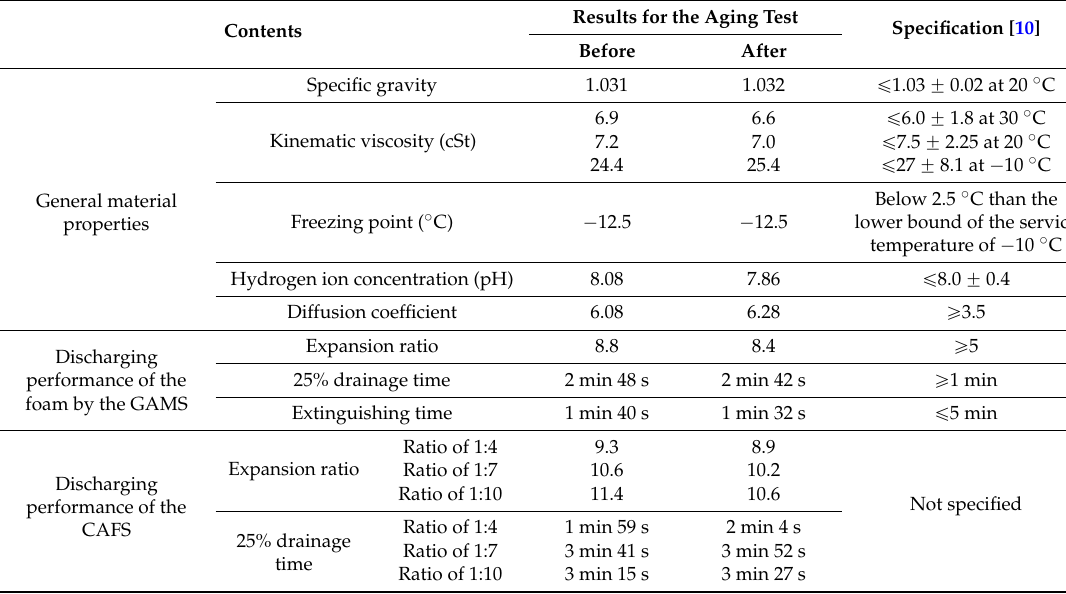
Table 2. Comparison of the physical and chemical performance for the aqueous film forming foam (AFFF) of